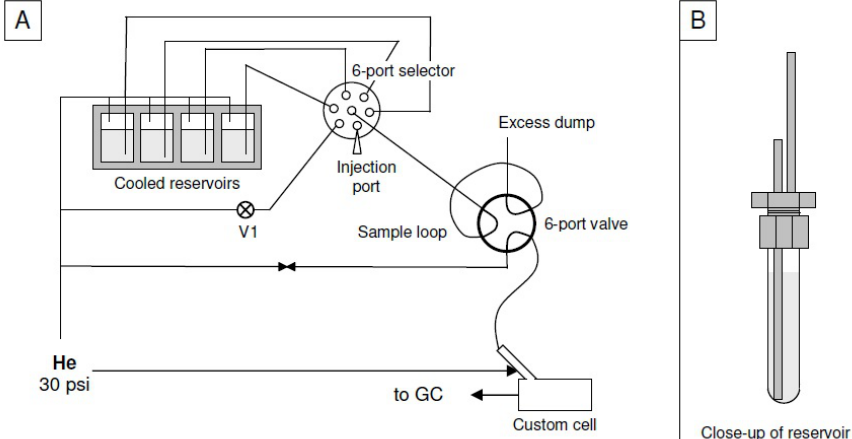
Fig. 1. Overview of the automatic injection system (AutoInject) showing (a) the schematic diagram of the system in “load” and (b) a close-up of a standard reservoir. The custom cell used in these studies is the collection and thermal desorption (CTD) cell of the TAG instrument (Williams et al.,